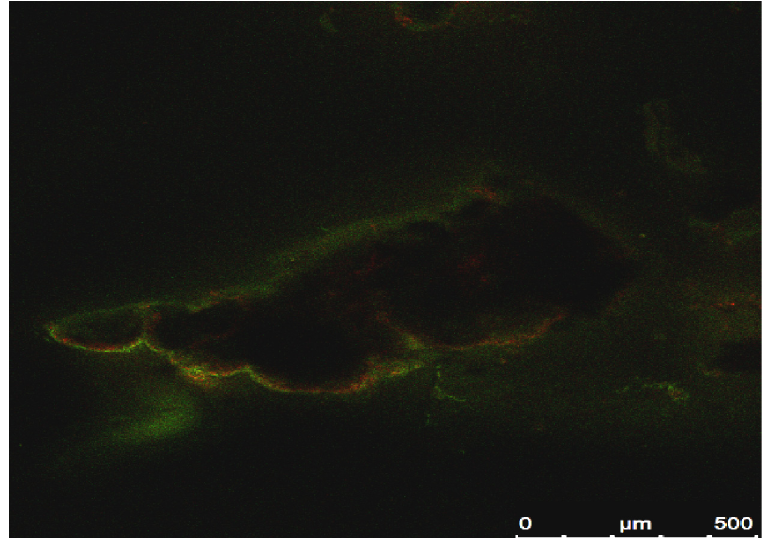
Figure 4. Fluorescence in situ hybridization (FISH) image of a biomass granule from a CANON bioreactor. AOB (green) and anammox bacteria (red) are displaced next to each other; the spatial organization of AOB and anammox bacteria inside the granule is determined by the syntrophic relationships among the